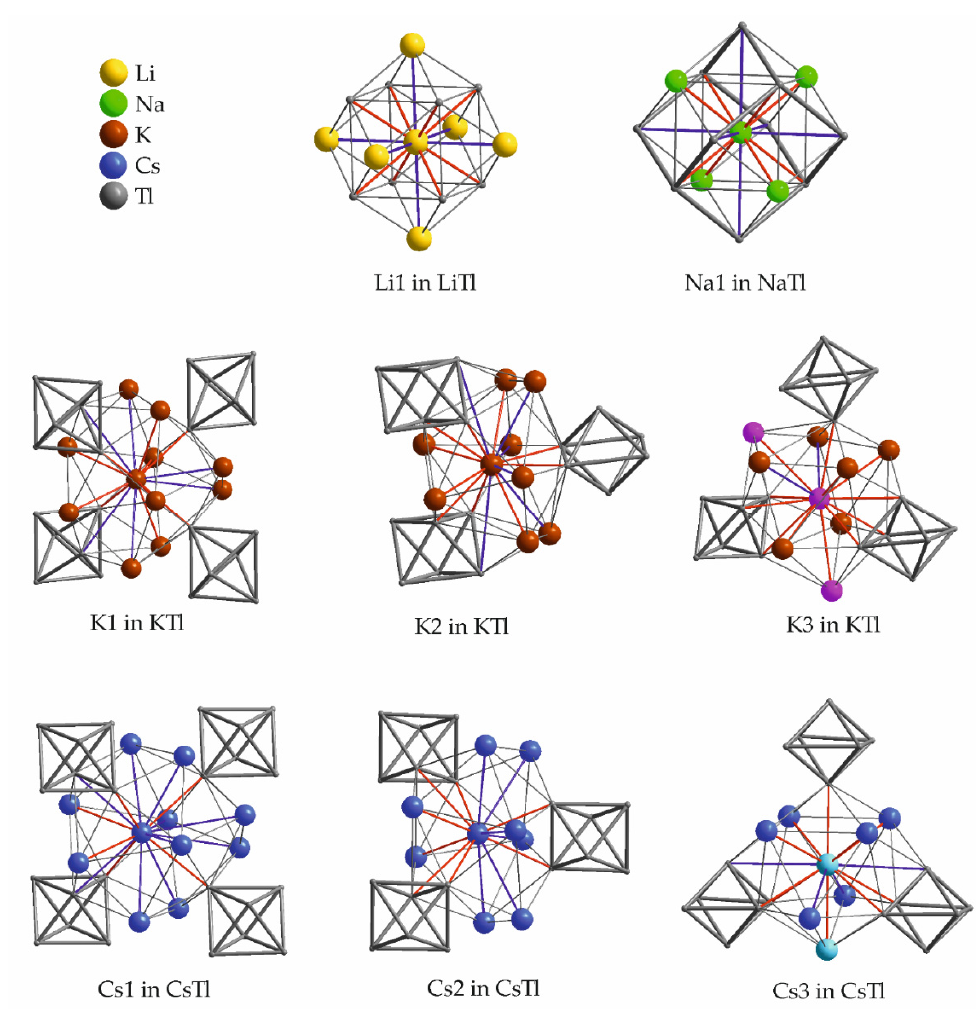
Figure 9. Atomic environment of the symmetry inequivalent alkali metals in crystal structures of binary ATl (A = Li, Na, K, Cs) at ambient conditions. The corresponding range of distances to the adjacent atoms as well as the Wyckoff letters are given in Tables 8–11. Shorter contacts are colored red, longer distances are given in blue. The color coding is also used in the corresponding tables. K3 and Cs3 are depicted in pink (K3) and cyan (Cs3) within their surroundings to illustrate the K3 zig-zag chains and Cs3 dumbbells.